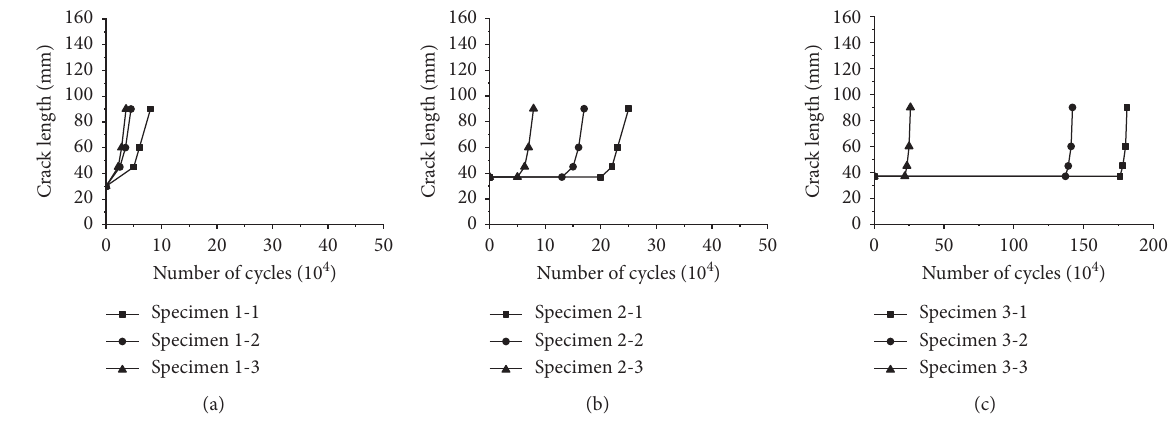
Figure 21: The curve of crack propagation. (a) Group 1. (b) Group 2. (c) Group 3.